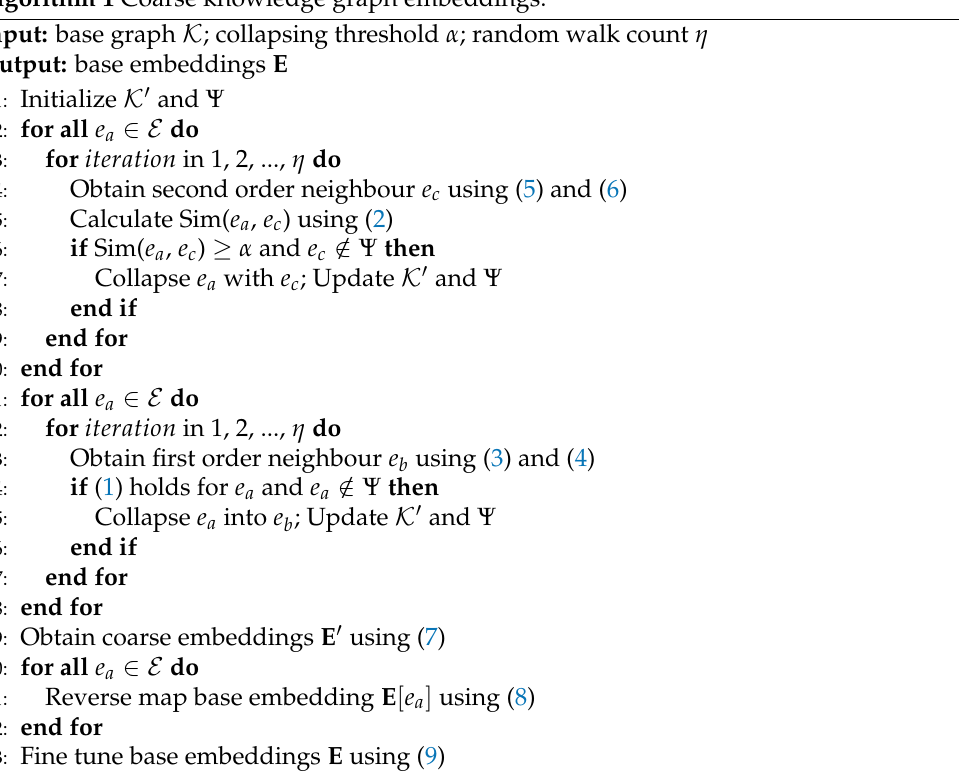
Algorithm 1 Coarse knowledge graph